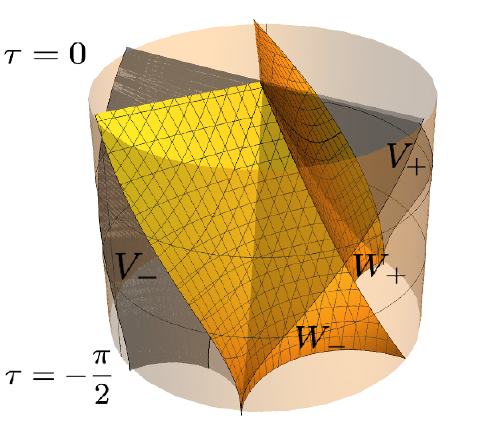
Figure 4 . 3D picture of identi(cid:12)cation surfaces in AdS 3 which correspond to the BTZ black hole creation in the rest frame in global